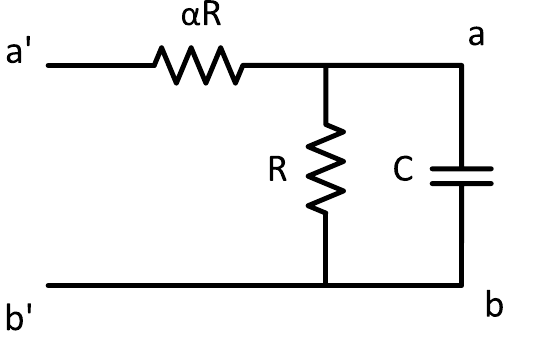
Figure 4. The ladder tile for the acTAM consists of resistors R and α R , and a capacitor C . The input nodes have glues a ′ and b ′ on top and bottom and the output nodes have glues a and b on top and bottom, both respectively.